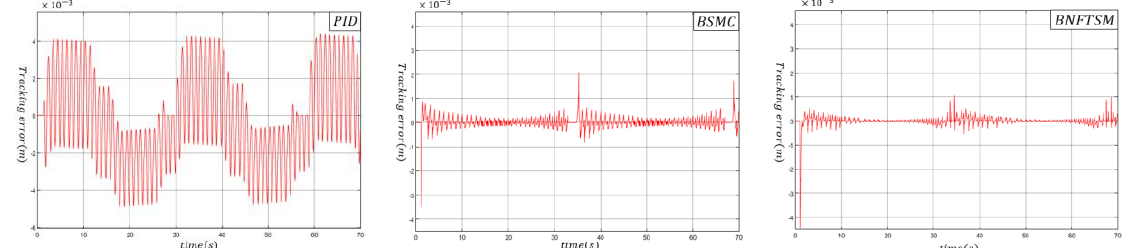
Figure 9. Tracking error curves of three controllers under variable load of 4000sin (𝑡)N : PID, BSMC, BNTFSM.